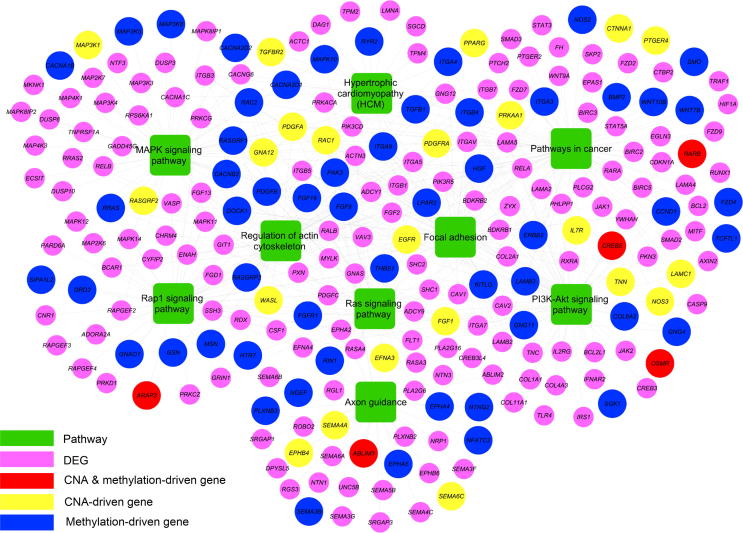
Characterization of the roles of CNAs and variations in gene body DNA methylation in cell culturesSignificantly enriched pathways of CNA/DNA methylation-driven genes. The genes used to construct the network included CNA/DNA methylation-driven genes and other Ra-specific DEGs that also participate in these pathways. CNA, copy number alteration; DEG, differentially expressed gene.